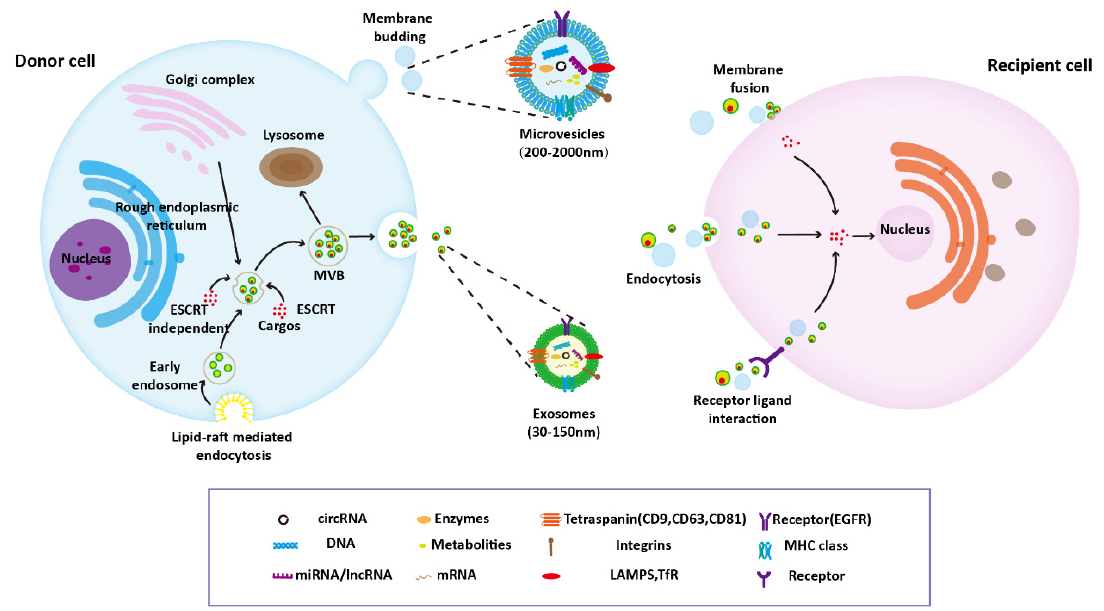
Figure 1. Classification, biogenesis, release, and uptake of EVs. Several stages–including endocytosis, endosome and MVBs formation, and exosomes release–are involved in the formation of exosomes. Microvesicles are released into the extracellular space through outward sprouting of the plasma membrane. EVs deliver their contents to recipient cells through endocytosis, ligand–receptor interaction, and direct fusion with the plasma membrane.